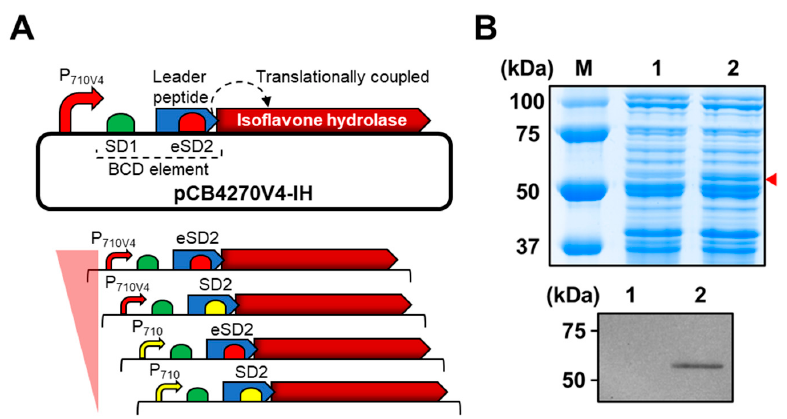
Figure 2. Expression of the gene encoding for IH in L. citreum for bioconversion of soy isoflavone glycosides. ( A ) Schematic diagram of bicistronic design (BCD) for expression of the gene encoding for IH. Up, plasmid pCB4270V4-IH constructed for the expression of the gene encoding for IH in L. citreum ; down, four different expression systems with different strengths of promoters (P 710 and P 710V4 ) and SD (SD2 and eSD2) parts. ( B ) SDS-PAGE and western blot analysis of IH gene expression in L. citreum harboring pCB4270V4-IH (P 710V4 and eSD2). Up, SDS-PAGE analysis. Lane M, molecular weight markers (kDa); Lane 1, soluble fractions of L. citreum wild type; Lane 2, soluble fractions of L. citreum harboring pCB4270V4-IH. Arrowhead indicates the band of IH; down, confirmation of IH by western blot assay. Lane 1, L. citreum wild type; Lane 2, L. citreum harboring pCB4270V4-IH.